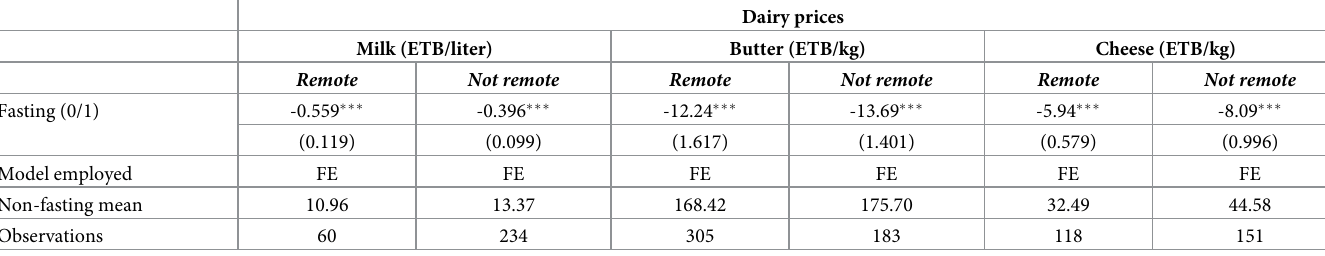
Table 10. Fixed effects analysis of heterogeneity in price differences by remoteness to Addis